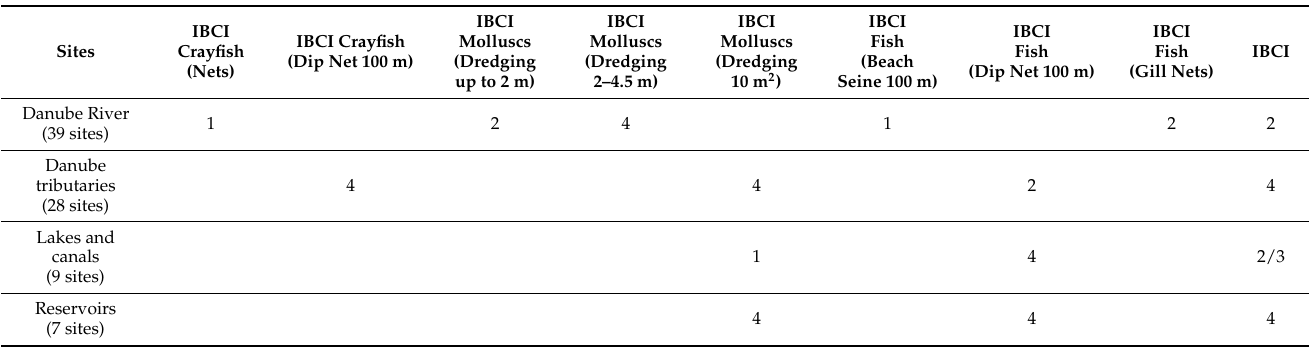
Table 3. Biocontamination of studied sites in Bulgaria during JDS4 (2019). IBCI–integrated biocon- tamination